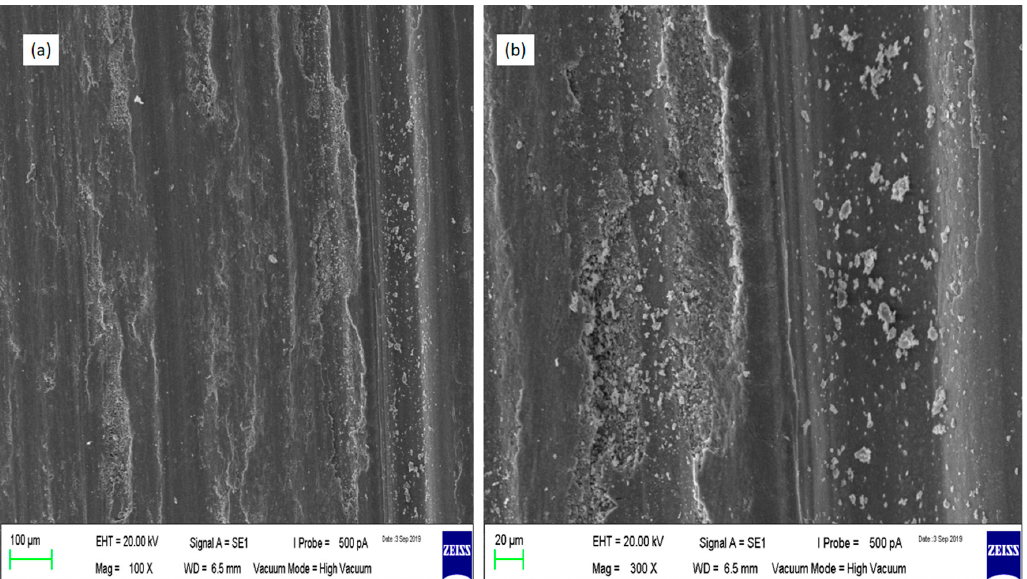
Figure 12. SEM micrographs of the wear tracks on Run 20 AA7075-SiC/fly ash surface composite samples ( a ) magnification 100× and ( b ) magnification 300×.